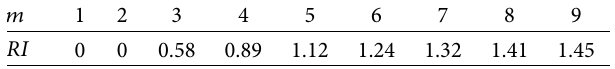
Table 3: Consistency index